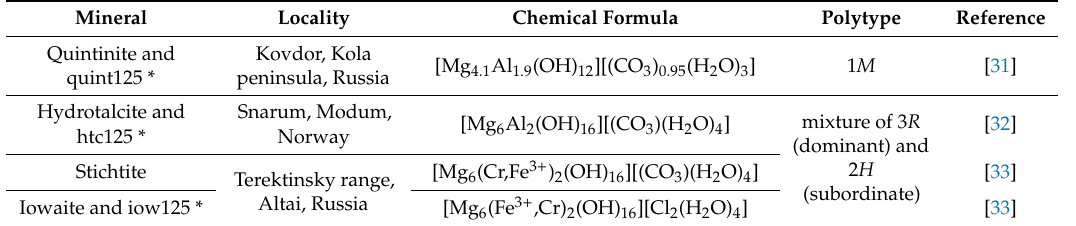
Table 1. Minerals and their annealed forms studied in this